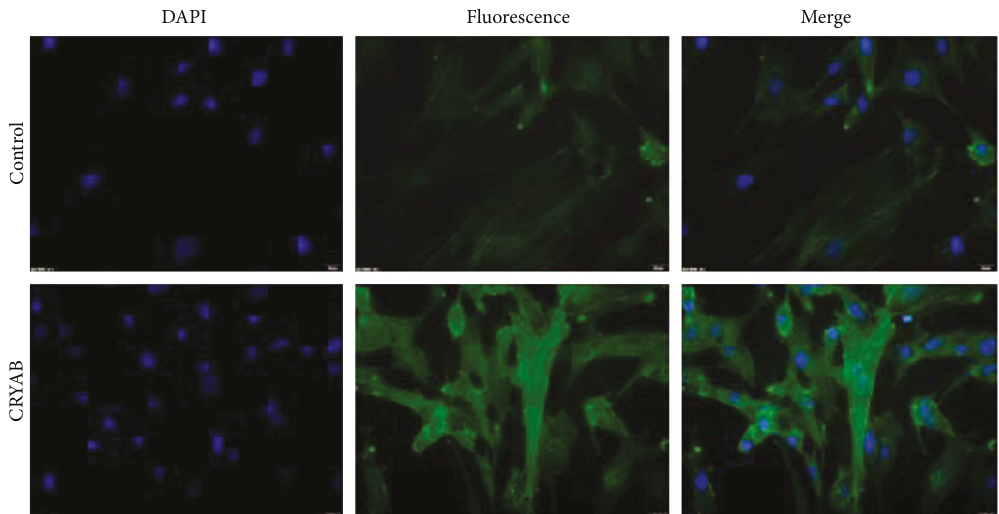
Figure 3: Immuno fl uorescence after incubation with CRYAB for 24 hours showed that F-actin protein in the CRYAB-treated TM cells irregularly accumulated inside the cell